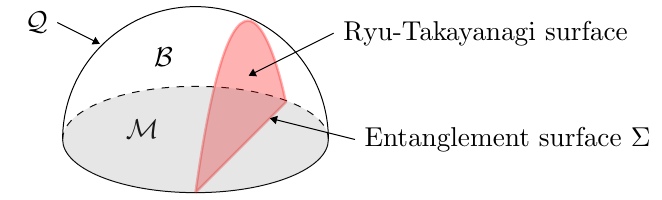
Figure 5 . The bulk AdS space B is surrounded by the union M [ Q of the boundary and bulk hemispheres. It is bipartited by the Ryu-Takayanagi surface anchored on the entanglement sur- face